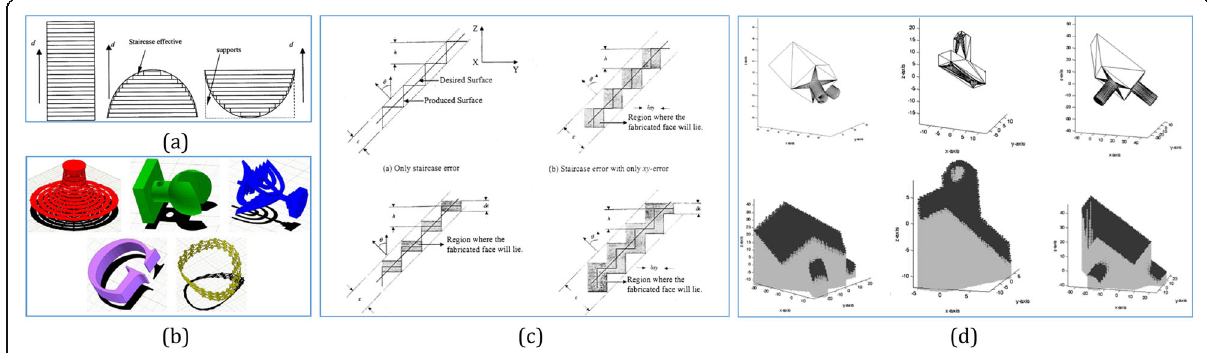
Fig. 11 a Effect parameters of build orientation [98]. b The models in their computed optimal orientations with the cast shadow of very small areas [99]. c Effect of xy -error and z -error on the flatness error [100]. d Optimal orientation for minimum support structures